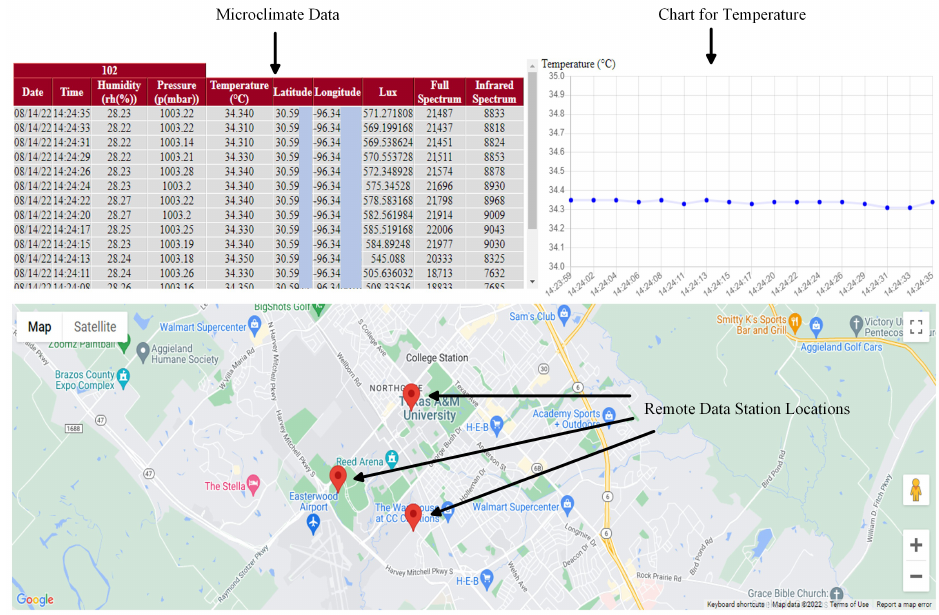
Figure 8. Data access over the